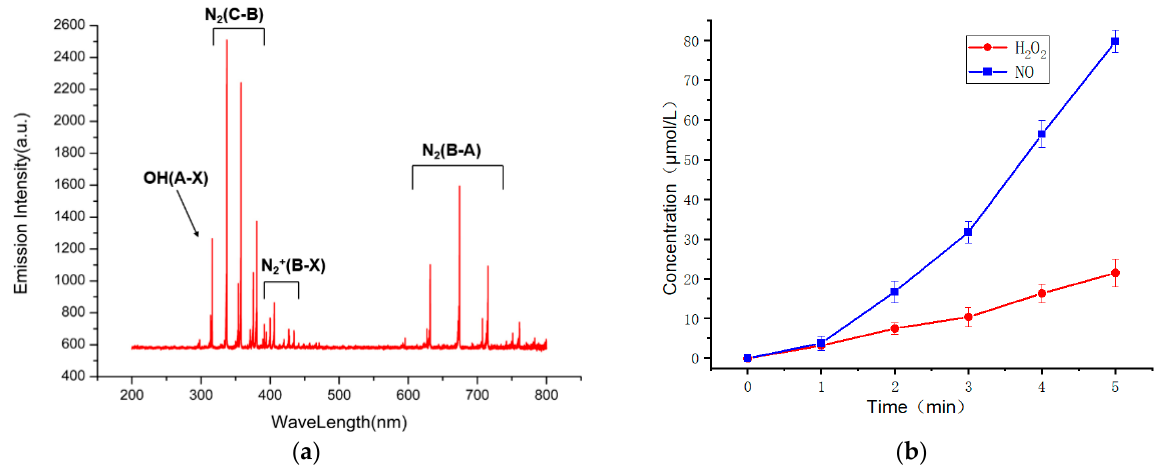
Figure 4. ( a ) Spectrogram of portable surface discharge; ( b ) Detection of liquid phase active particles in portable plasma activated water.